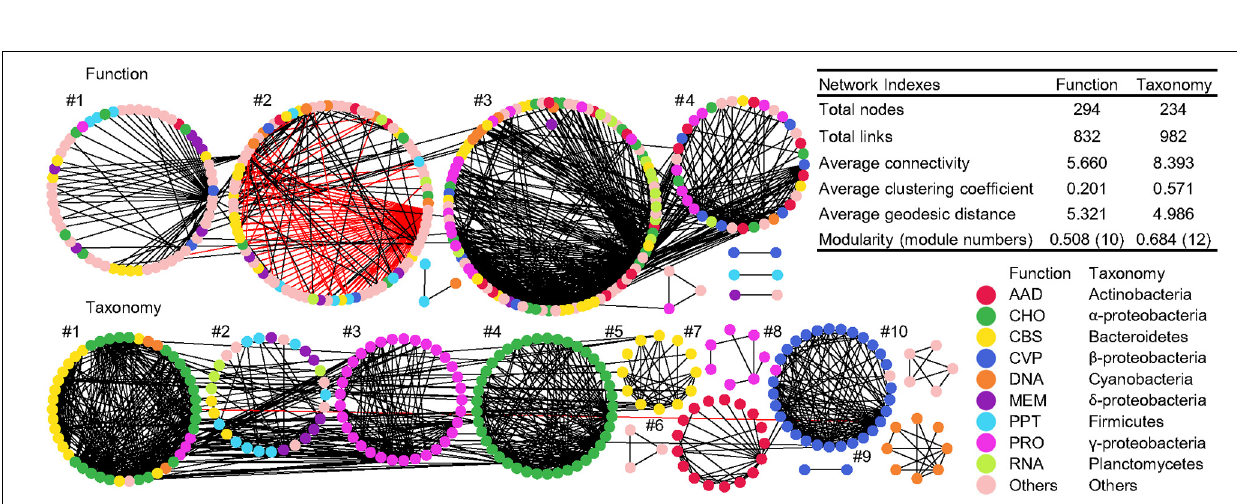
FIGURE 6 | Co-occurrence networks of functional and taxonomic compositions. Network graphs with submodule structures of water metagenomes annotated in Subsystems L3 (Function) and RefSeq at the genus level (Taxonomy). Node color represents classification of Subsystems L1 (Function) or RefSeq at the phylum/class levels (Taxonomy). A black edge indicates a positive interaction between two nodes, while a red edge indicates a negative interaction. Summary of key network indexes is given in the table.